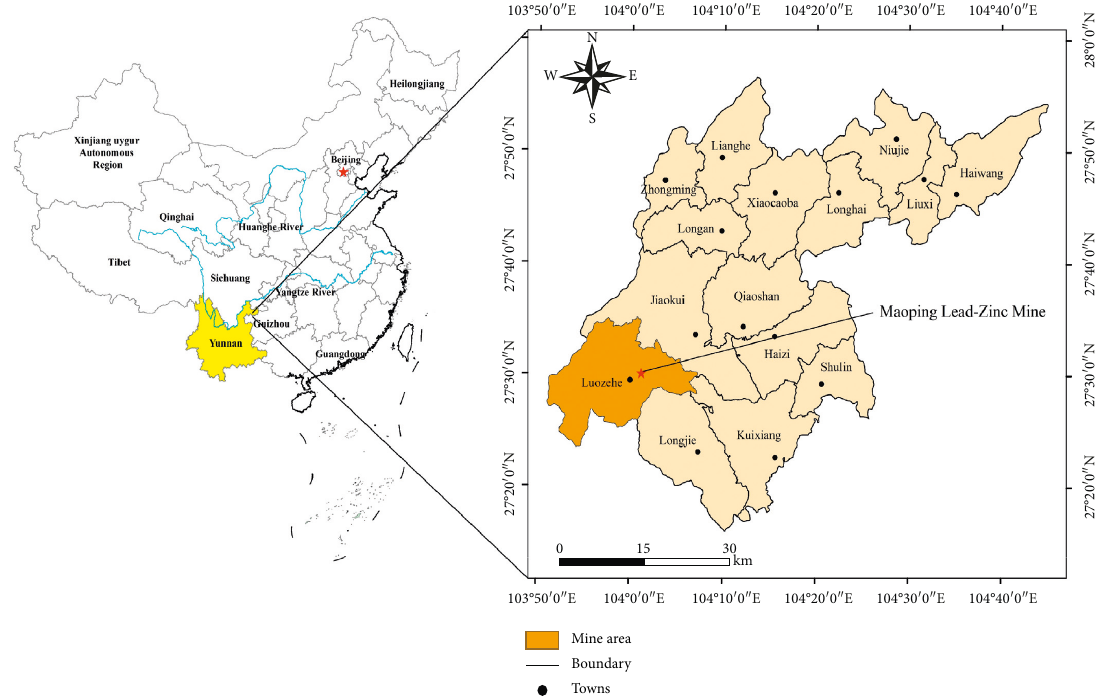
Figure 2: Geographical location of the mining area.